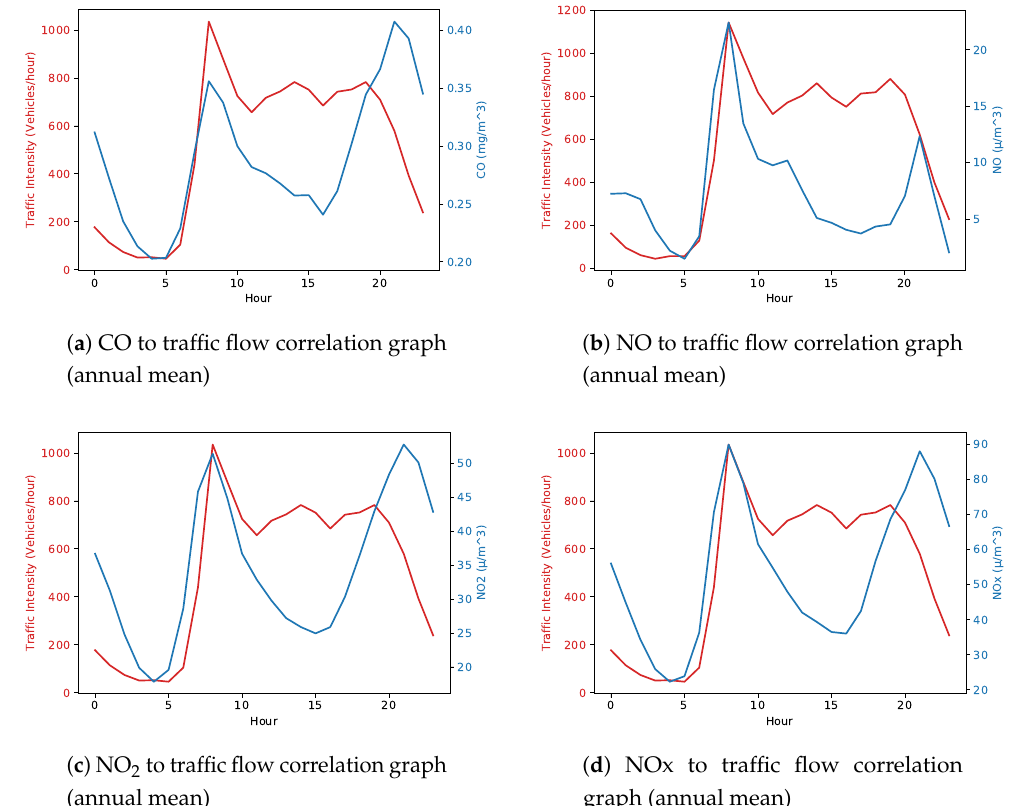
Figure 6. Correlation graphs of traffic flow and air pollutants with respect to each hour of the day (annual mean).